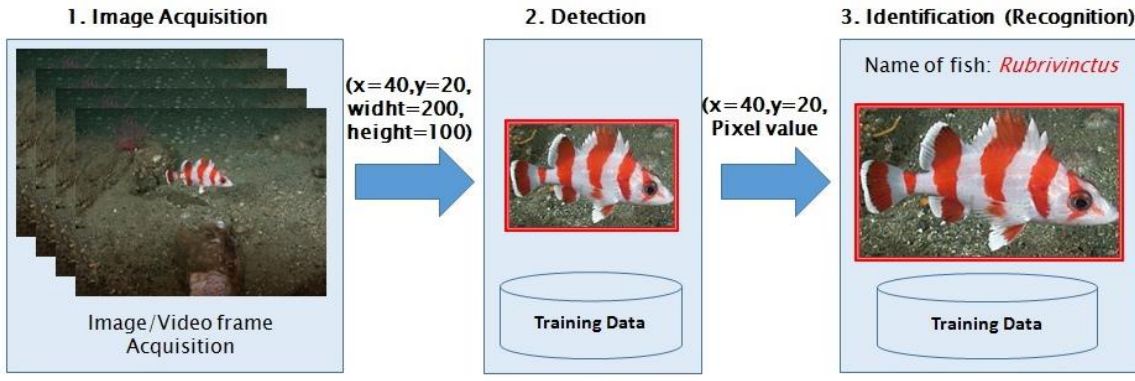
Figure 2. Example system that detects and classifies fish in images (Matai et al.,